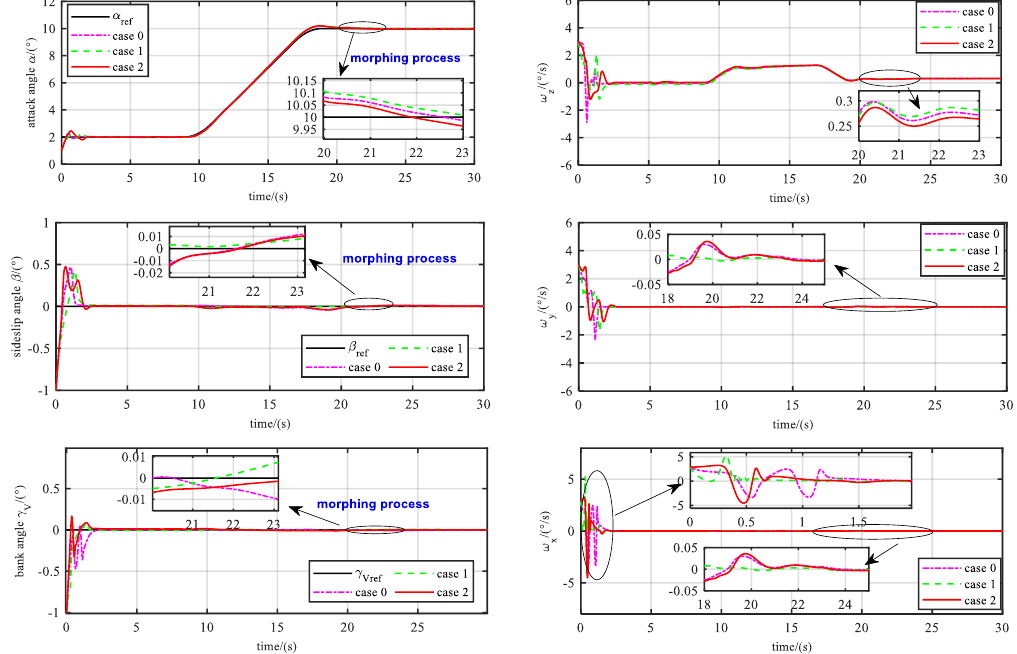
Figure 8. Tracking performance under three cases. In case 1, the dynamic pressure and moment coefficients are larger. So the system owns stronger control efficiency, causing higher requirements for the servo.